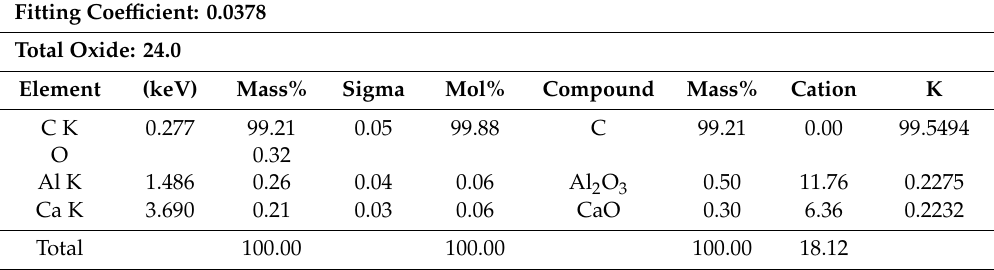
Table 10. The Oxide of resin reinforced Hemp ( Bohmeria nivea ).